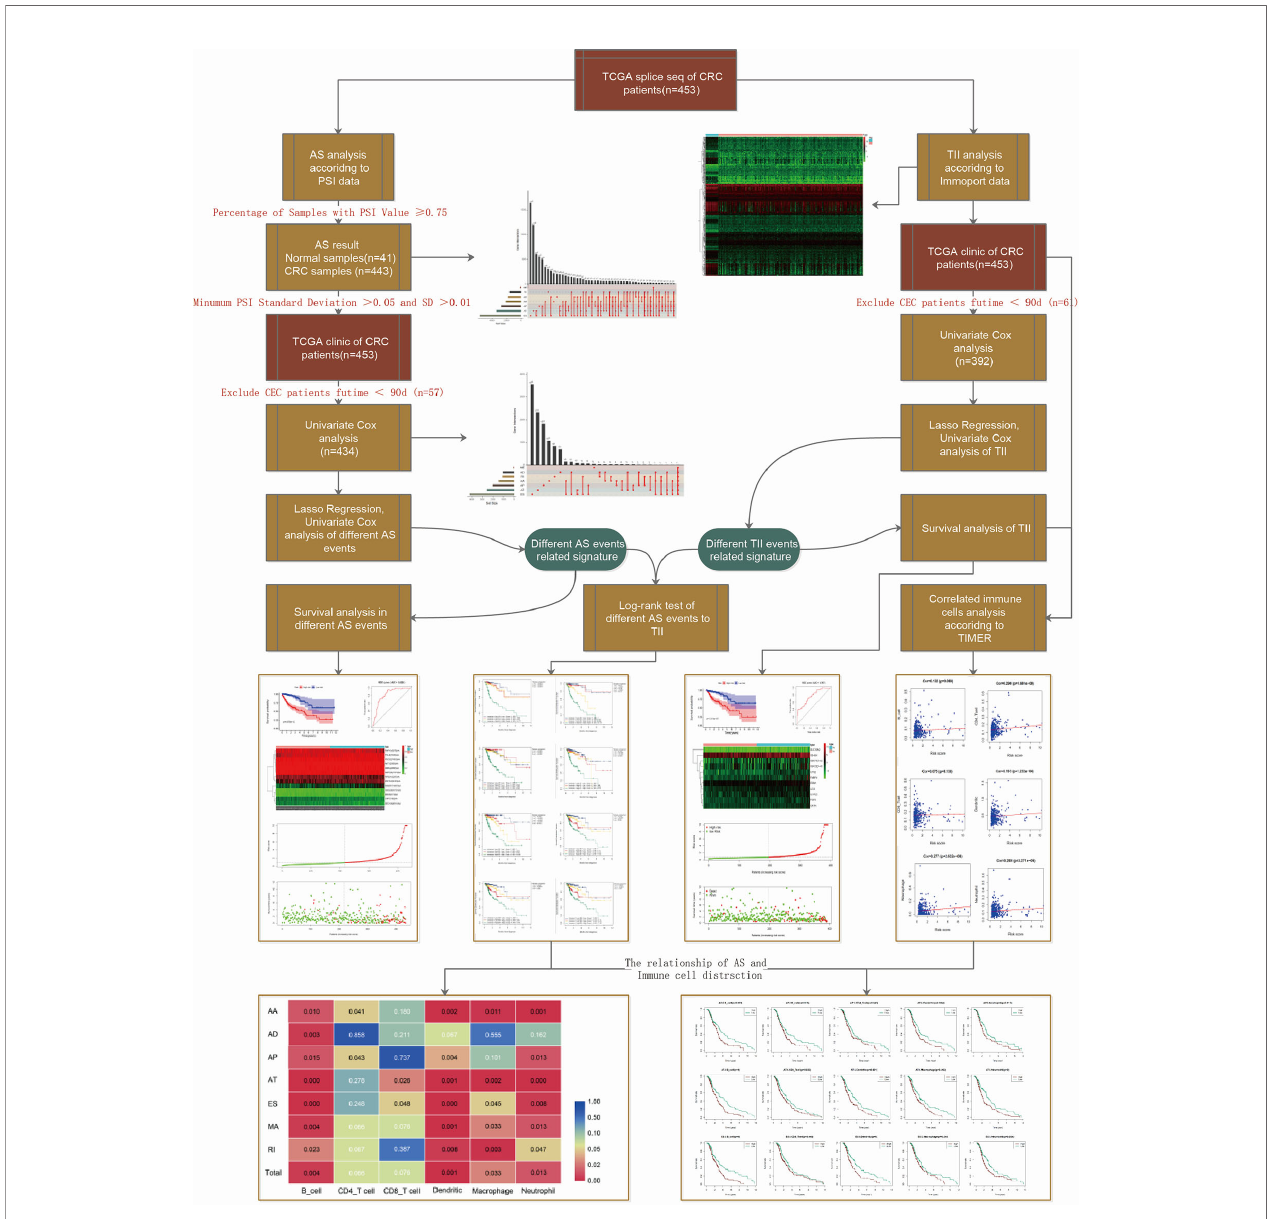
FIGURE 1 | Schematic representation of the work- fl